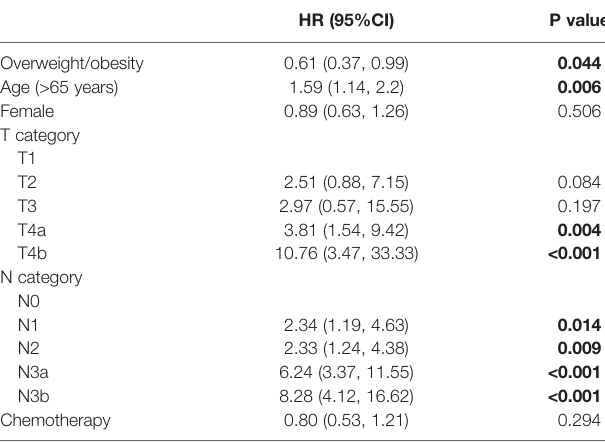
BMI, body mass index; HR, hazard ratios; CI, con fi dence interval. Bold values represent statistically signi fi cant differences (P <